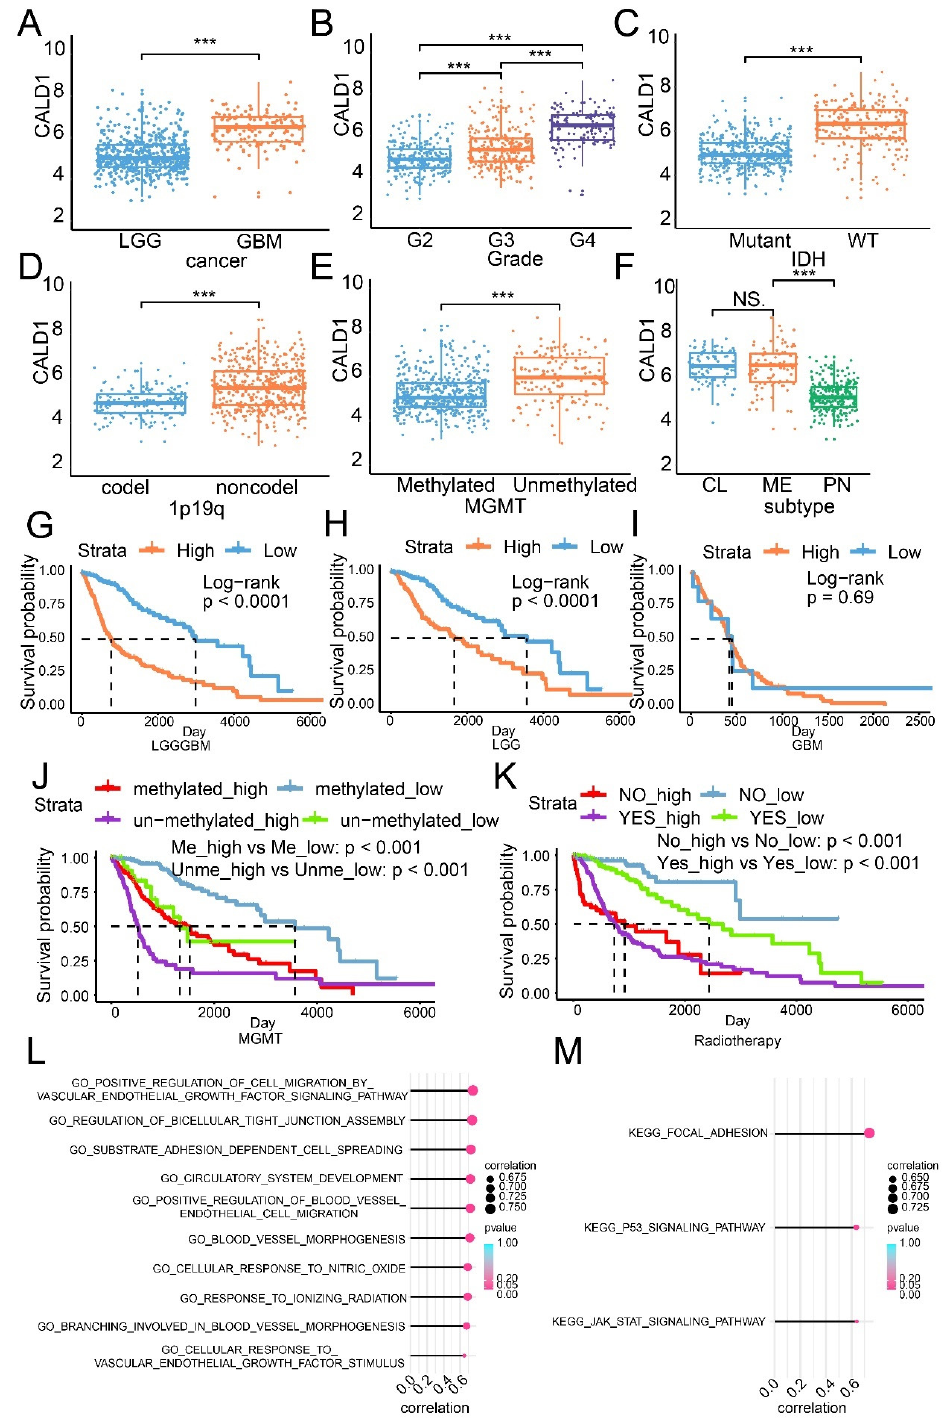
Figure 1. The expression profile, the overall survival analysis and pathways prediction based on CALD1 expression in the TCGA dataset. The distribution of CALD1 in cancer ( A ), WHO grade ( B ), IDH status ( C ), 1p19q status ( D ), MGMT status ( E ) and glioma subtype ( F ). The overall survival analysis based on the LGGGBM cohort ( G ), the LGG cohort ( H ), the GBM cohort ( I ), MGMT status ( J ) and radiotherapy ( K ). ( L , M ) The correlation between CALD1 expression and pathways from the GO/KEGG enrichment analysis. NS: no statistical difference; ***: p value <